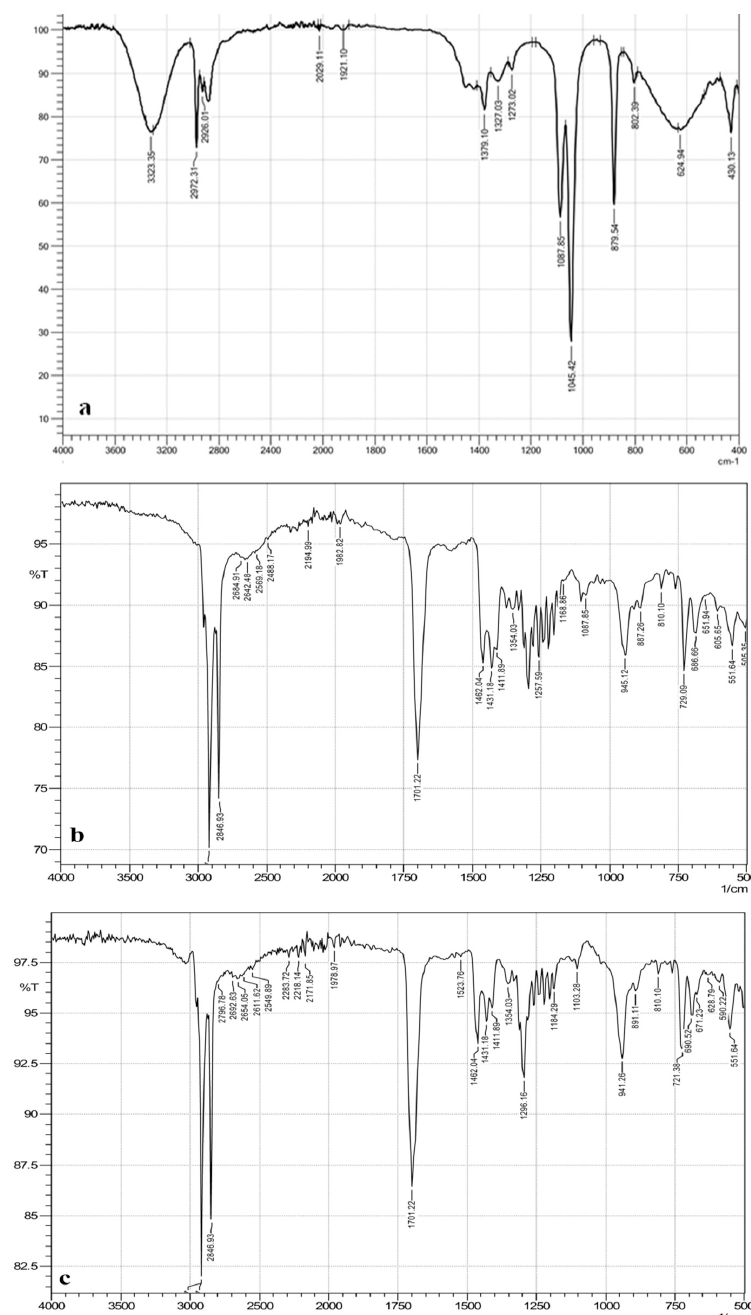
Figure 9. ATR-FTIR spectra ( a ) for pure E307, ( b ) modified surface of SS type AISI 410S in ethanolic solution of SA with the addition of 2.0% of E307 for one hour [27], ( c ) modified surface of SS type AISI 410S in ethanolic solution of SA with the addition of 2.0% of E307 after 120 h of immersion in simulated solution of acid rain with pH = 3 (transmittance vs.